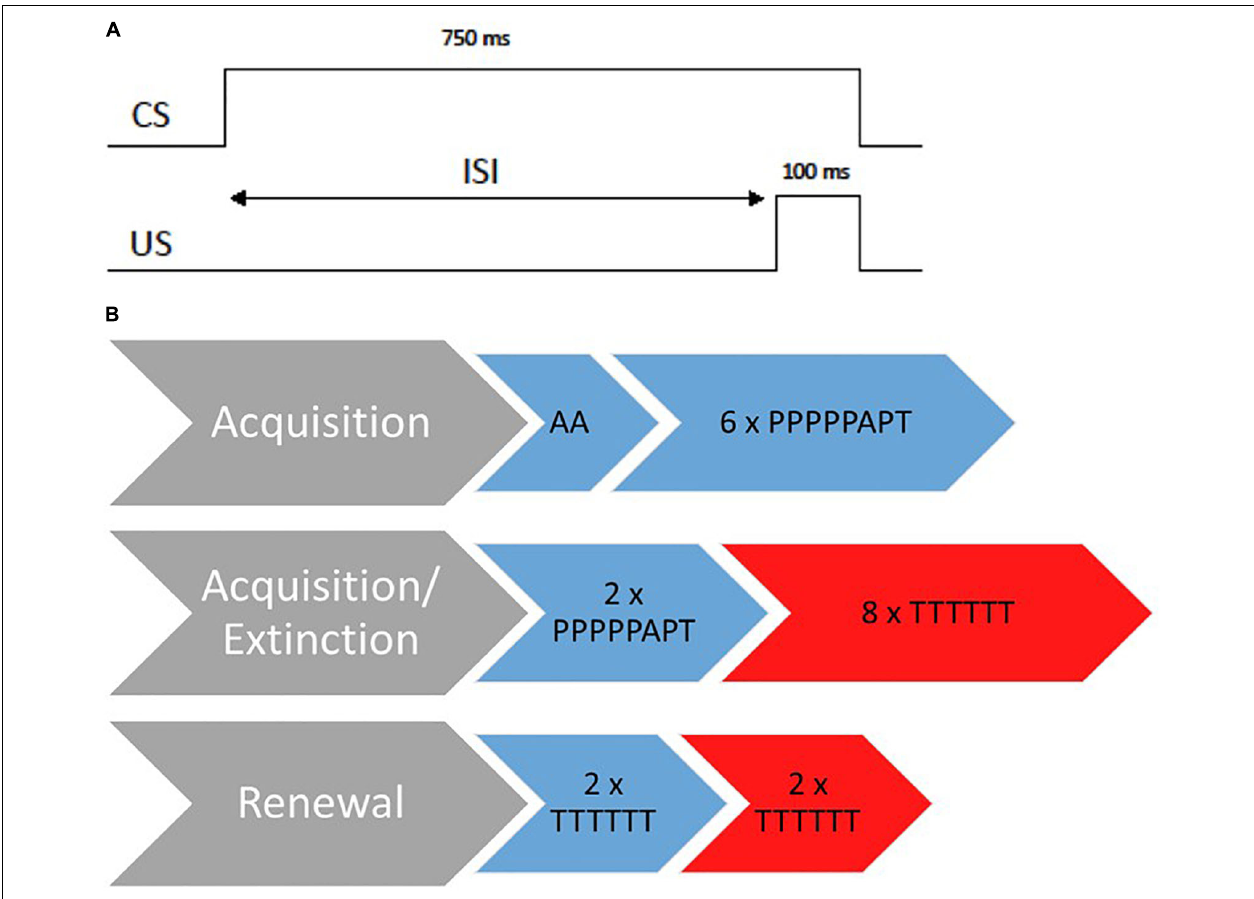
FIGURE 1 | Overview of the 3-day EBC paradigm. (A) Standard delay paired trails during acquisition. CS, conditional stimulus; United States, unconditional stimulus; ISI, interstimulus interval. (B) Design of the 3-day paradigm. The procedure is displayed for an ABAB design whereas blue stands for the acquisition context and red for the extinction context. A, Air puff alone trials; P, paired trials; T, tone alone